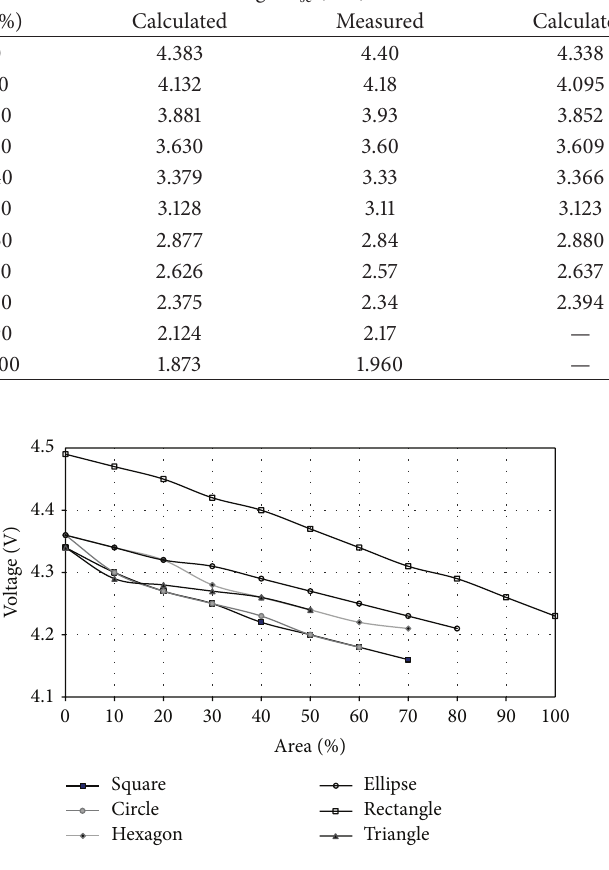
Figure 7: Comparison of voltage values obtained for opaque areas on light source. Table 2: Measured and obtained values for hexagon and circle shape areas indicating the relation between area and short circuit current of solar module.